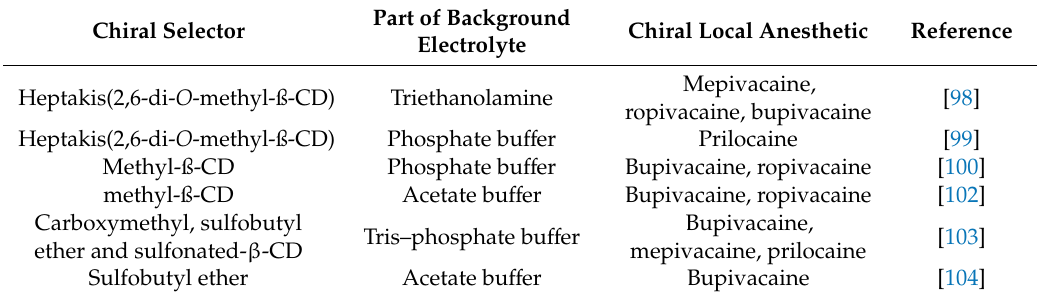
Table 3. Chiral selectors and background electrolyte used in capillary electrophoresis of local anesthetics. Chiral